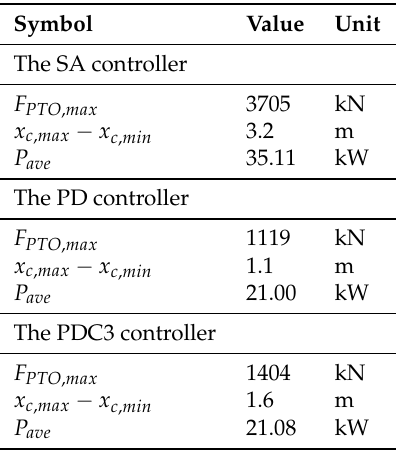
Table 3. Capacity requirement of the controllers without hydraulic system.